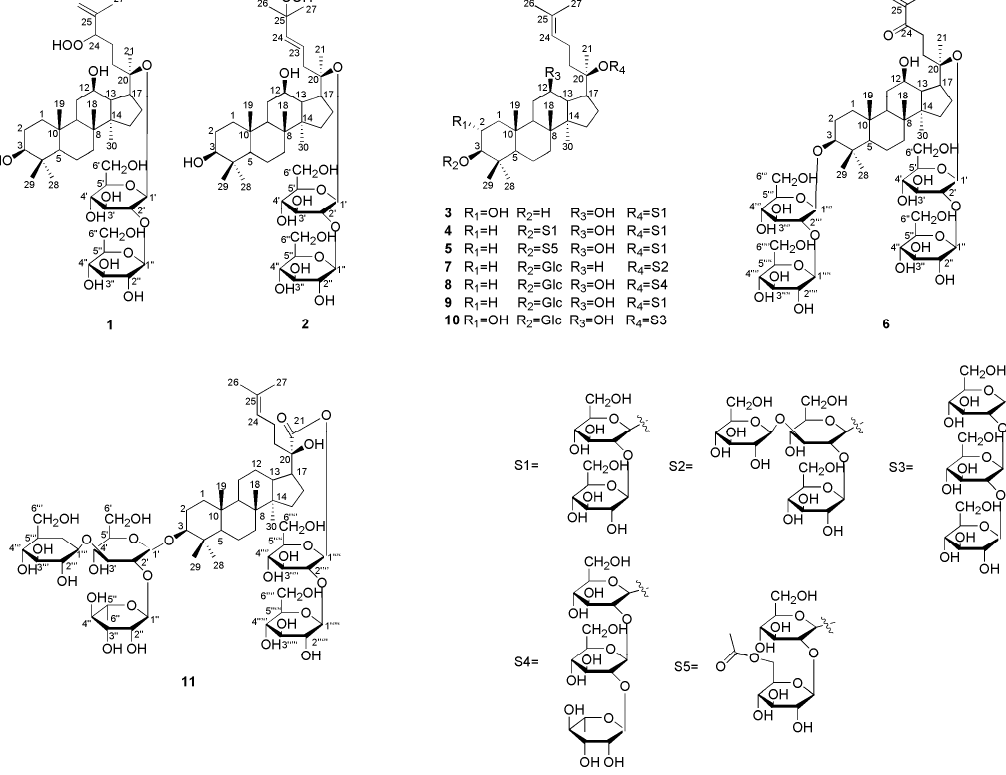
Figure 1. Chemical structures of compounds 1 – 11 .